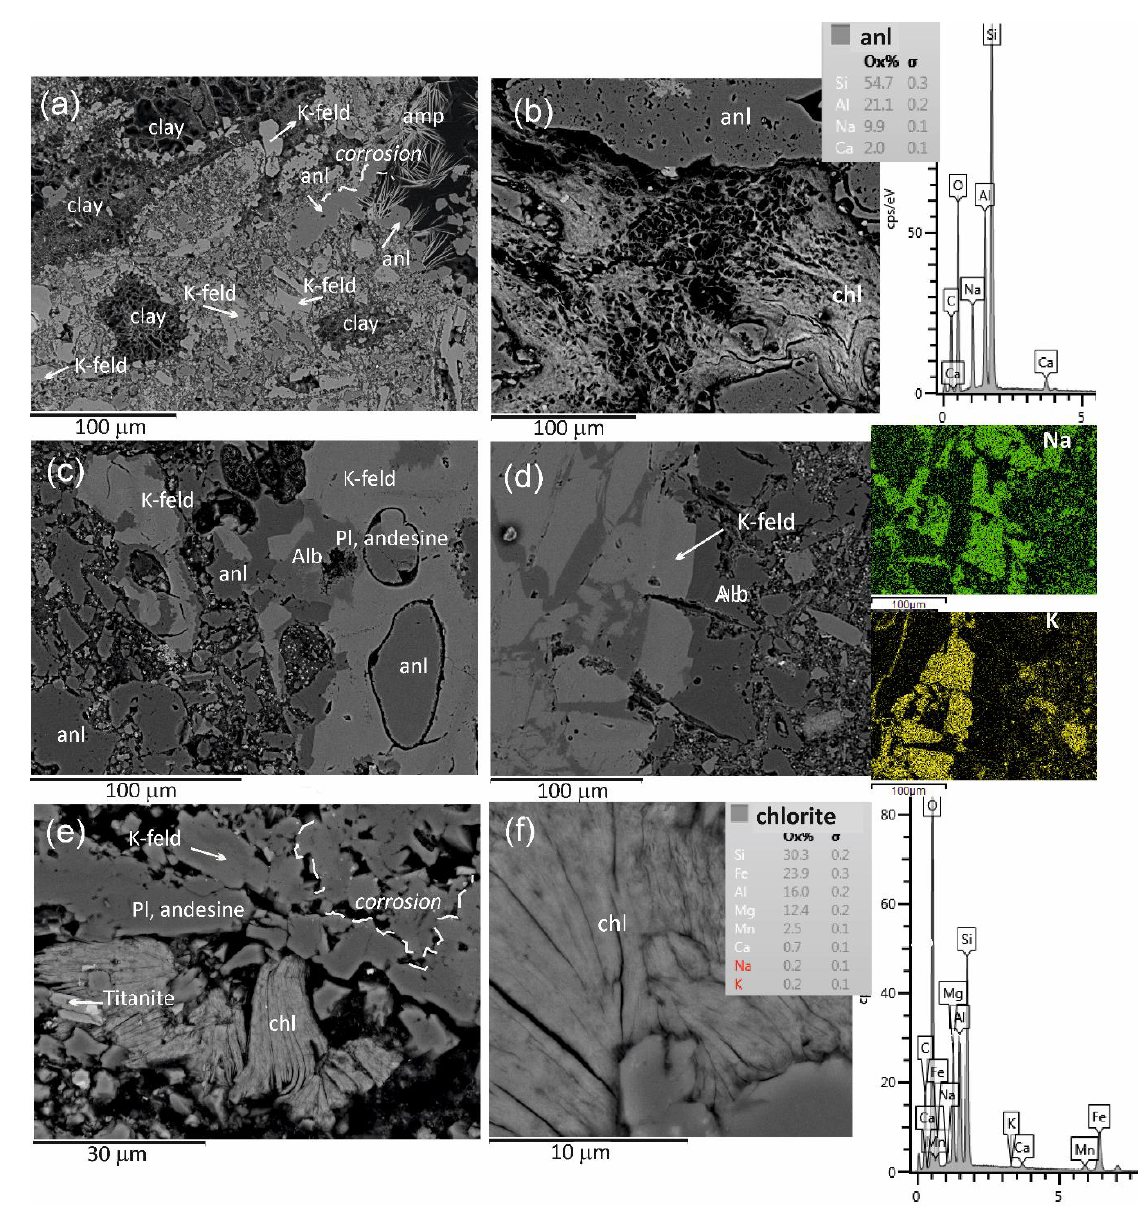
Figure 5. The reservoir rocks cored in the San Vito 1 borehole under the electron microscope ( a – f ) with representative EDS spectra and maps (on the right). ( a,b ) The yellow tuff cored at 804 m of depth from the argillic facies, shows a complex texture characterized by widespread K-feldspar microcysts constituting the matrix and clay filling voids. Analcyme with an anhedral habit and corroded edges is present as alteration products; it has a low Na content. EDS indicates chlorite compositions among argillic phases. ( c,d ) The chaotic tuff core from 1412 m of depth from the phyllic facies presents a mosaic of analcyme and K-feldspar microcrysts. Locally, K-feldspar is replaced by albite (see EDS maps for Na and K elements). ( e , f ) The chaotic tuff cored at 1713 m of depth from the propylitic calcium–aluminum–silicate facies characterized by the corroded K-feldspars and well-formed chlorites. Chlorite is Fe-rich (see the EDS spectra at the right bottom panel). Abbreviation: K-feld, K-feldspar; chl, chlorite; anl, analcyme; clay, argillic zones; Pl, plagioclase; Alb, albite, Amp, amphibole. Dashed lines indicate the main corrosion zone along the crystal rims.